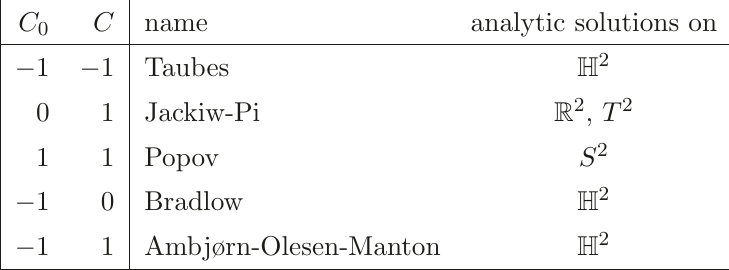
Table 1 . Vortex equation constants C 0 and C for five different